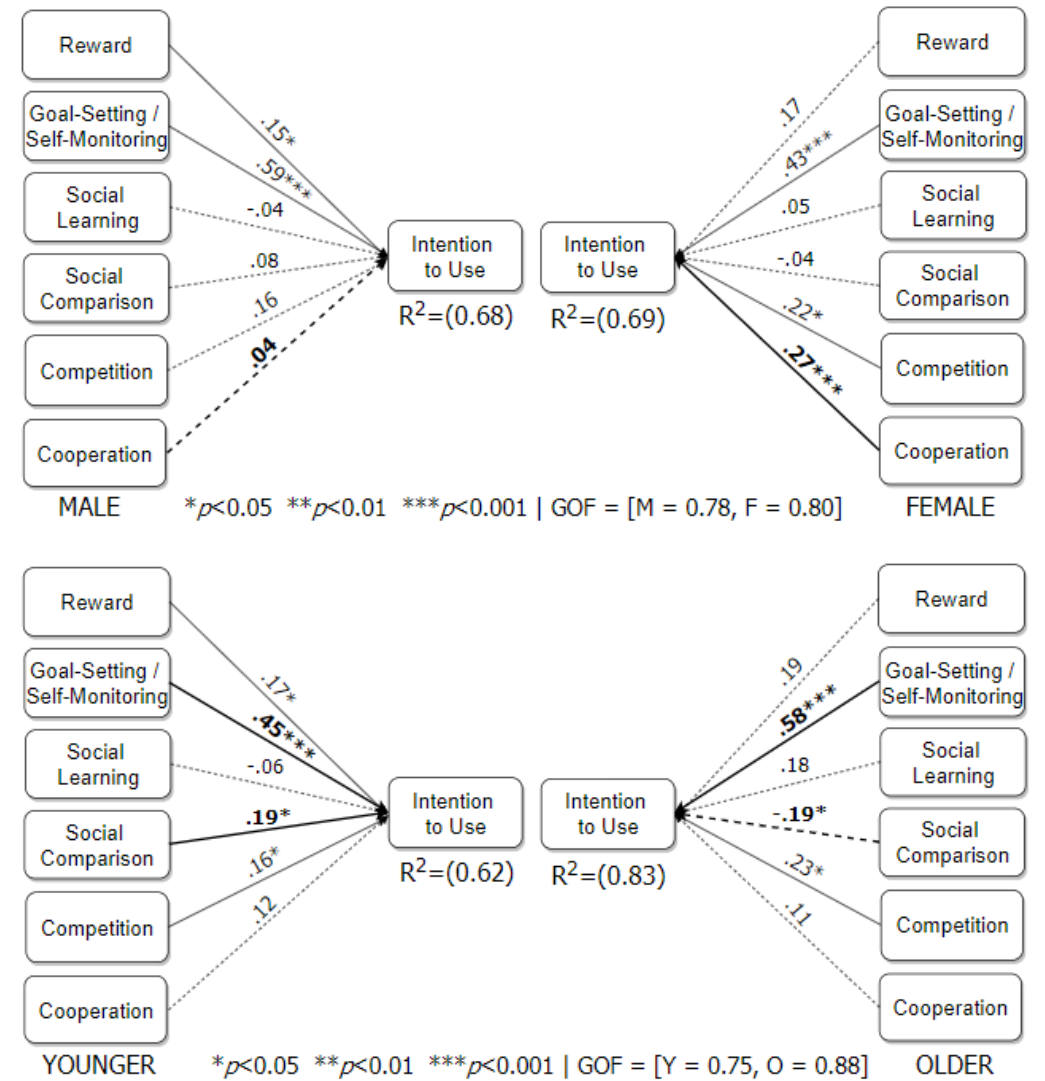
Figure 6. Gender-based submodels (above) and age-based submodels (below). The bold path indicates where the two subgroups in question significantly differ at p < 0.05. Younger people (18–34 years old) and older people (34+ years old).